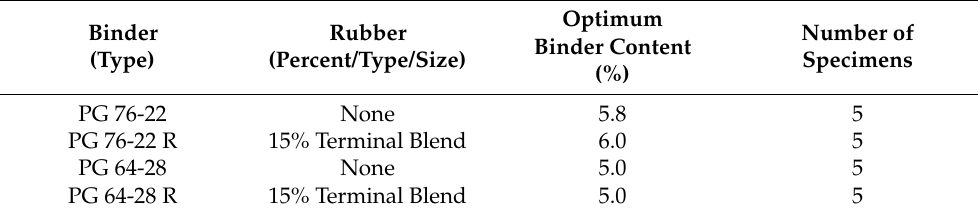
Table 3. Optimum binder content.